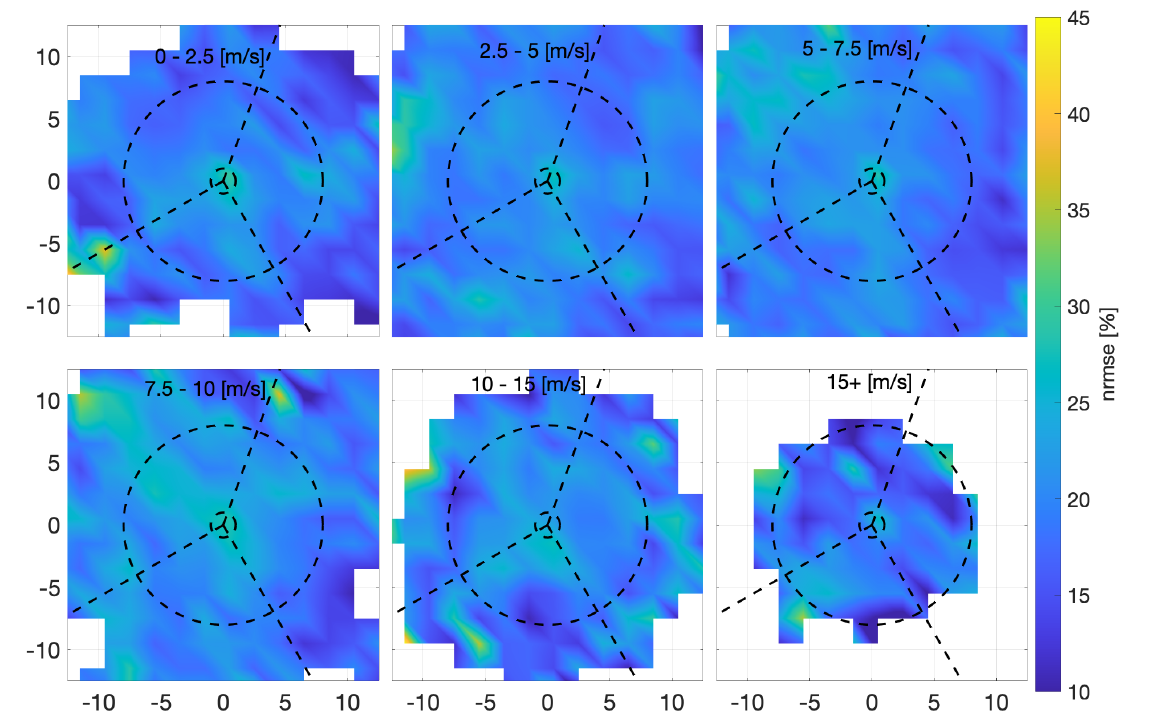
Figure 16. As in Figure 14, each subplot parsed by forward translation velocity. Figure 18 shows nrmse for various rmw bins. For the smallest storms, rmw ≤ 30 km, there is very high nrmse ( ∼ 50%) around the eye and high levels everywhere within R = 8. For the next rmw bin, rmw = 30–45 km, nrmse is milder (40%) and more confined. The trend continues as rmw